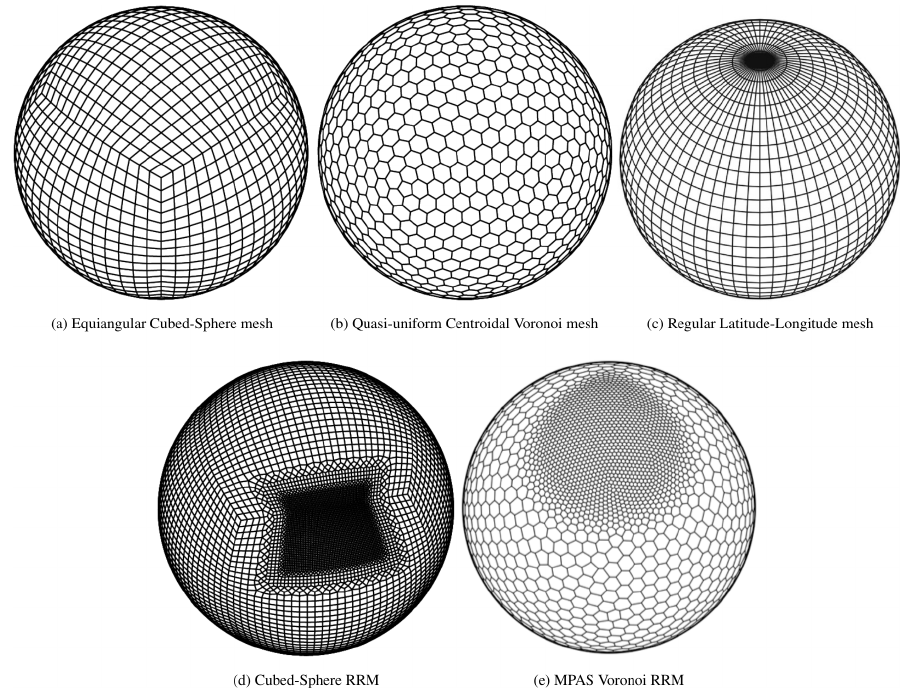
Figure 1. A depiction of the five meshes studied in validation, unit testing, and intercomparison of the regridding